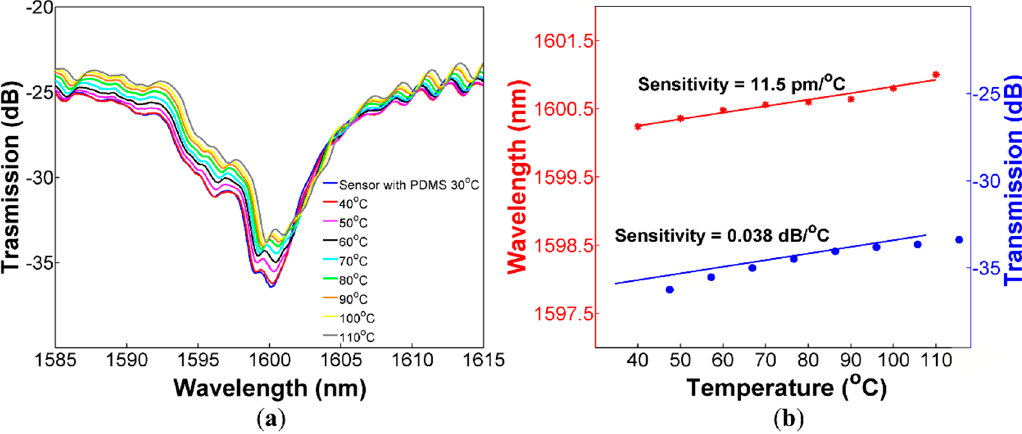
Figure 7. ARROW sensor covered with PDMS ( a ) Spectral response of the device for temperature from 30 to 110 ◦ C; ( b ) Dip wavelength shift and transmitted intensity changes as a function of the applied